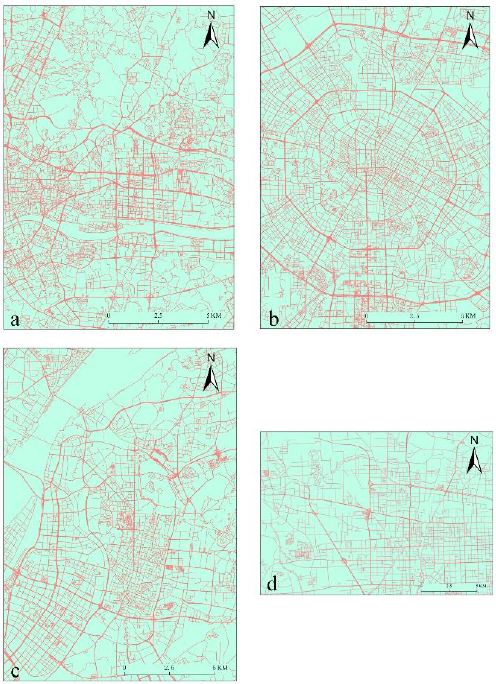
Figure 2. Urban road networks of Guangzhou ( a ), Chengdu ( b ), Nanjing ( c ), and Shijiazhuang ( d ).